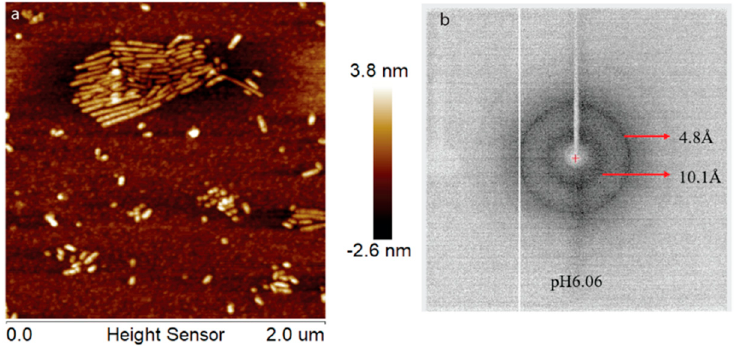
Figure 2. AFM image ( a ) and XRD image ( b ) of H175 assemblies formed at pH 6.0 after 14 days’ incubation at 37 °C. The arrows in (b) indicate the equatorial and meridional reflections at 10.1 Å and 4.8 Å, respectively.